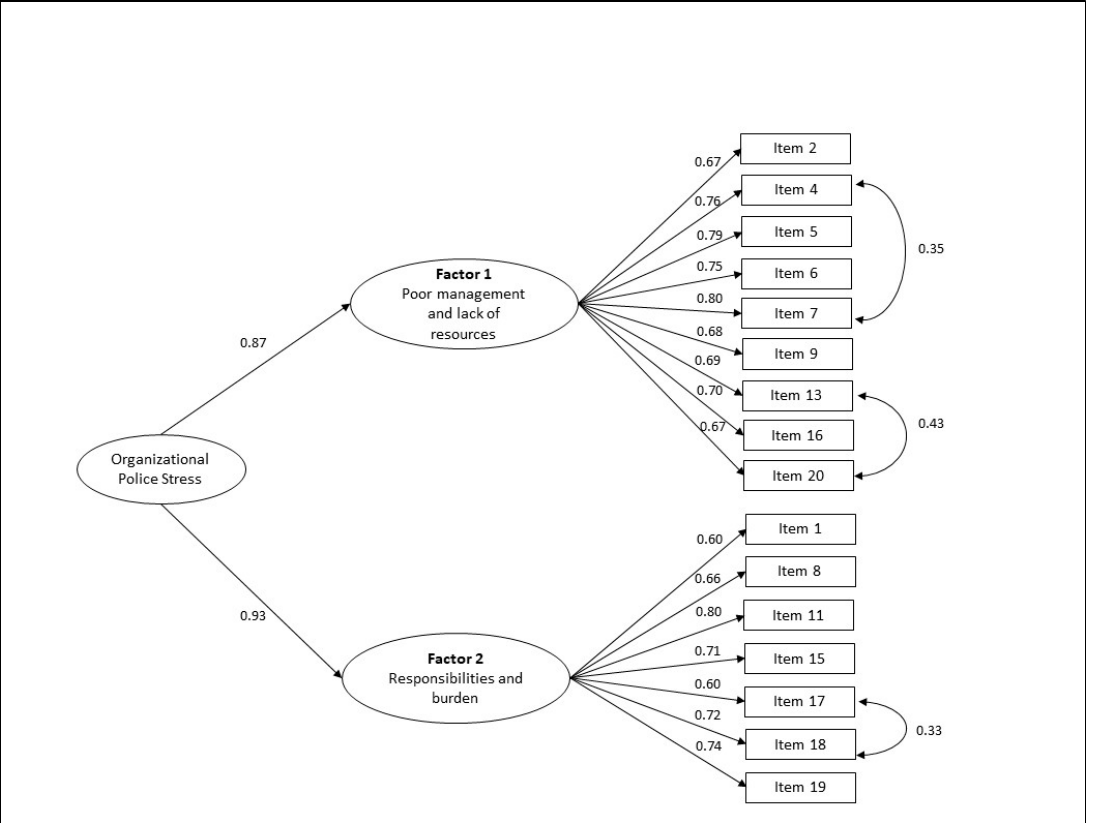
Figure 1. Second-order model for the PSQ-Org (Database 2; n = 792).